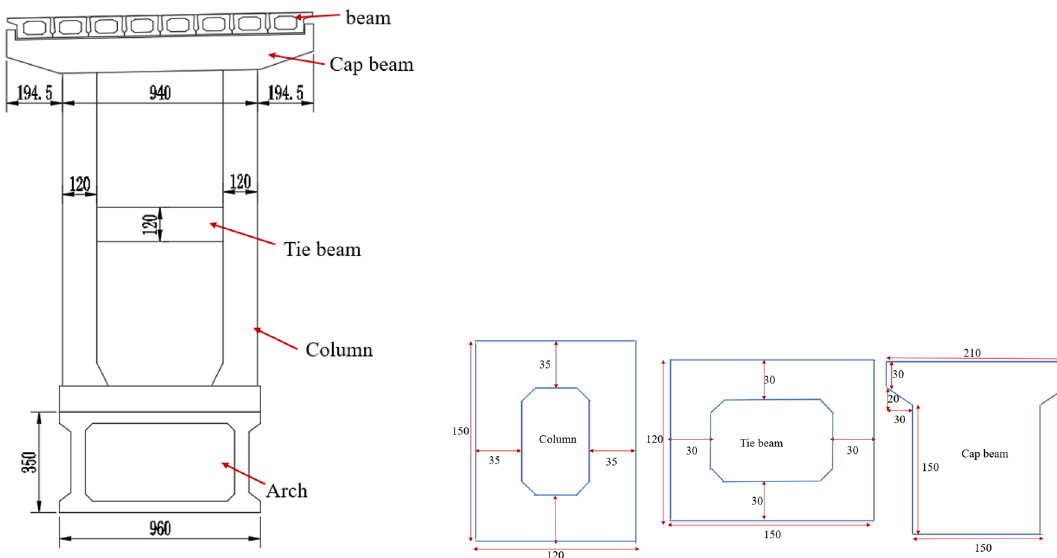
Figure 6. The column information diagram (unit: cm).